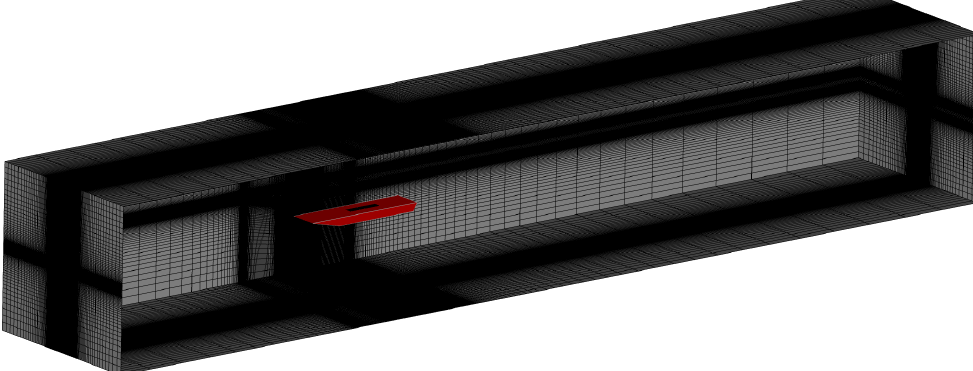
Figure 3. Computational grid at the far-field boundaries for the wind tunnel model.